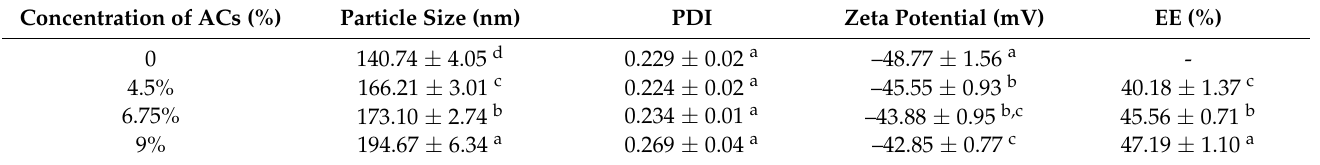
Table 2. Mean particle size, PDI, zeta potential and encapsulation efficiency of fabricated nanoliposomes. Concentration of ACs